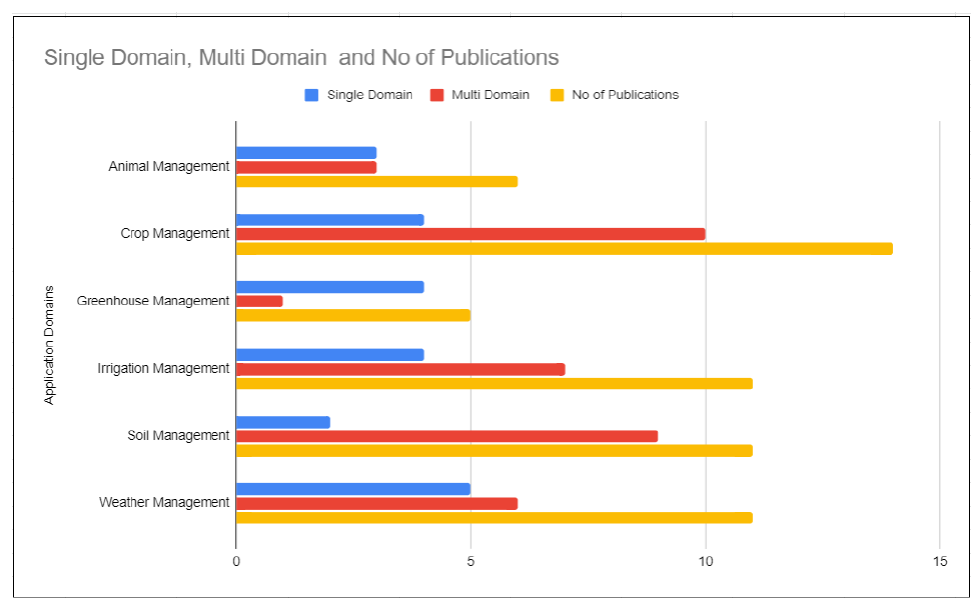
Figure 3. Application